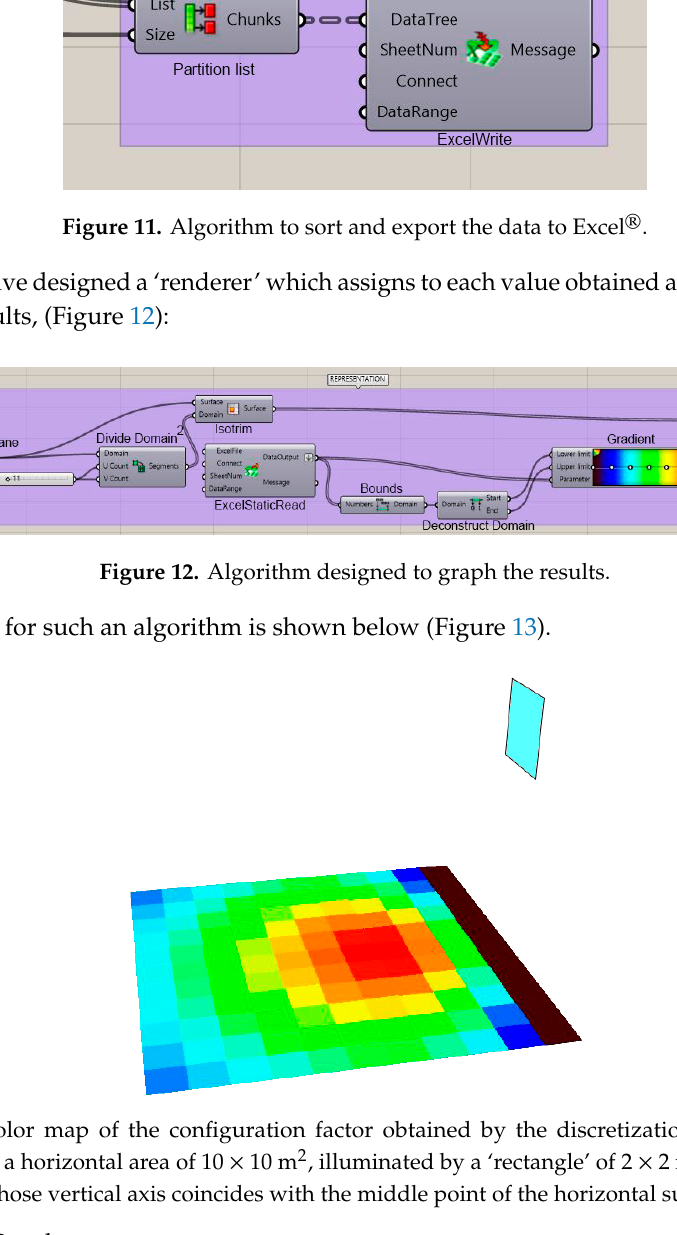
Figure 10. Visualization of the intersections between the ‘radiant cones’ and the unit spheres and their corresponding projections on the chosen plane.